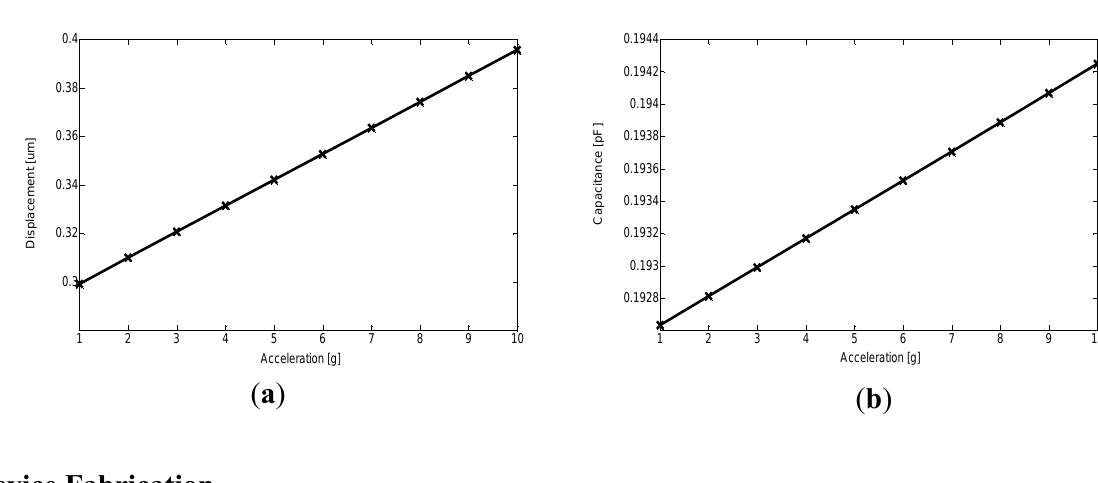
Figure 6. CoventorWare simulation results for displacement ( a ), and capacitance change ( b ), both under acceleration ranging from 1 to 10 g.